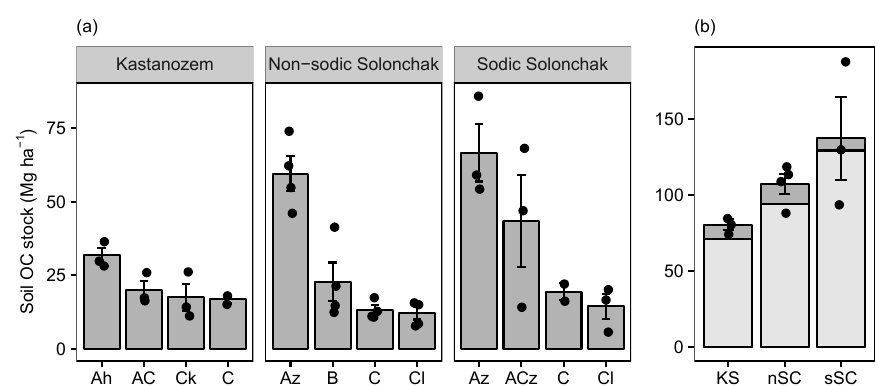
Figure 2. Soil OC stocks (Mgha − 1 ) for three soil types (a) as a function of horizon and (b) for a depth of 100cm and the entire soil profile (light and dark gray). The mean depths of the profiles were 157 ± 20cm (KS), 175 ± 9cm (nSC), and 141 ± 5cm (sSC). Given are the arithmetic means ± standard error of the mean, and the dots show individual measurements (in plot b for the entire soil profile). Abbreviations: KS is Kastanozem, nSC is non-sodic Solonchak, sSC is Sodic